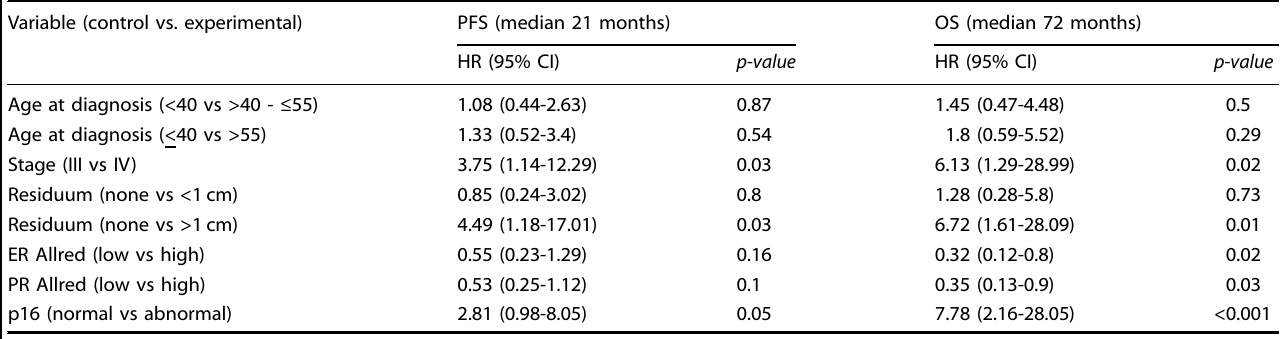
Table 4. Multivariable survival analysis (Cox regression) results in stage III/IV LGSOC. Variable (control vs.